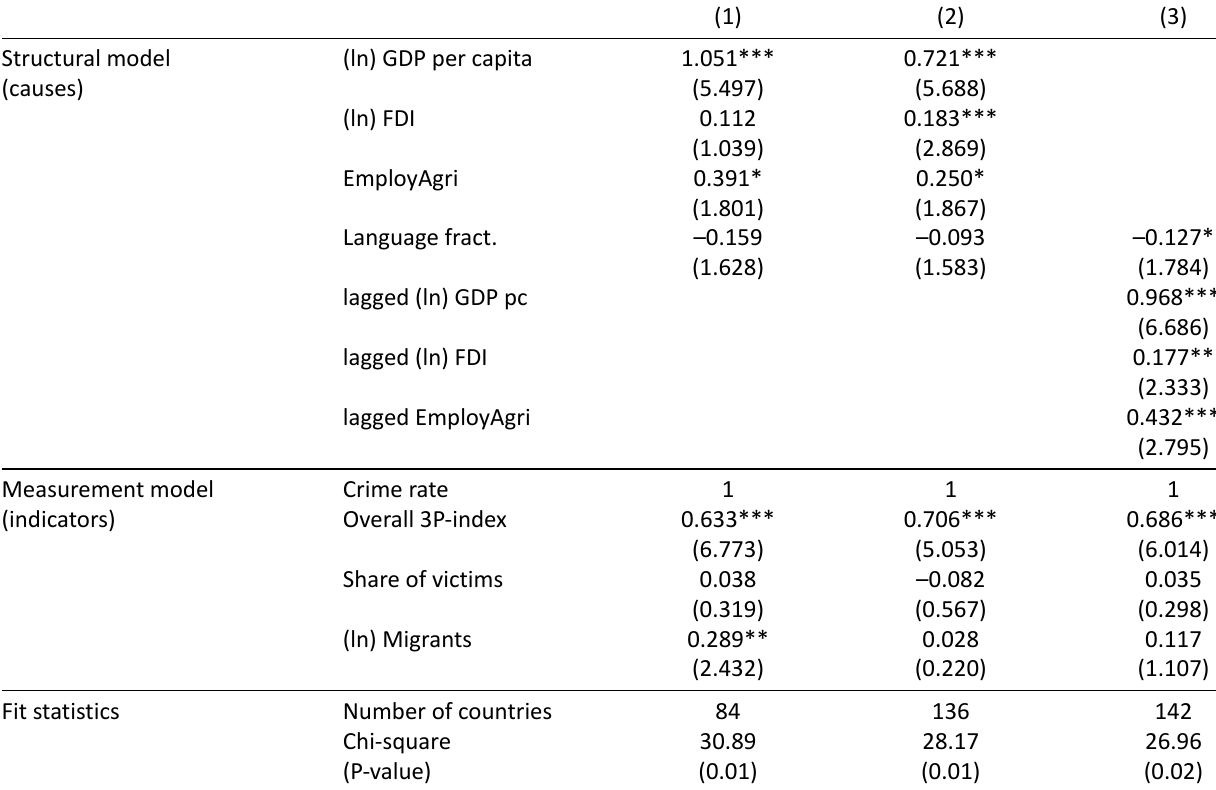
Table 2. MIMIC estimates (robustness